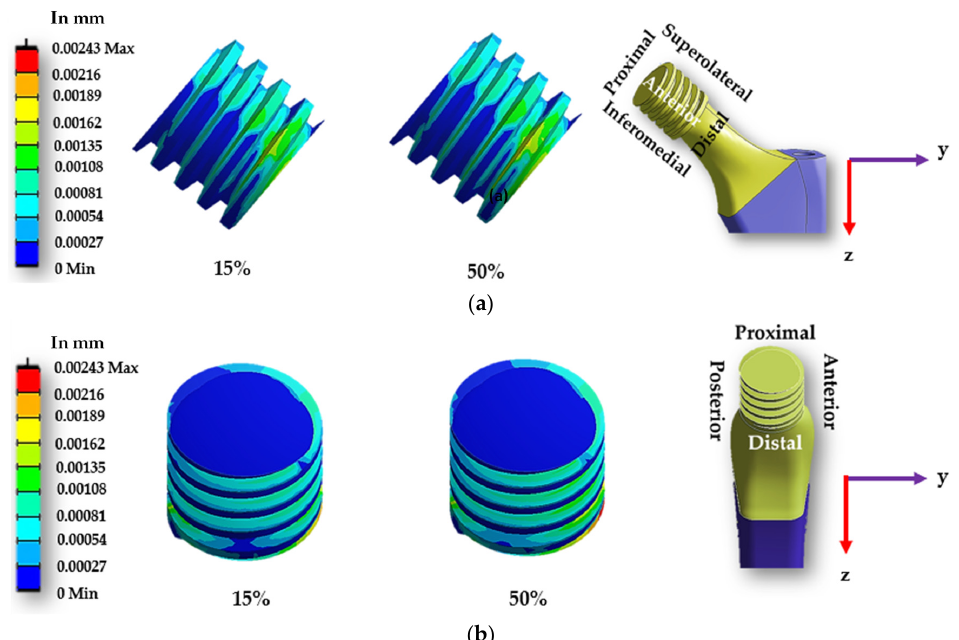
Figure 15. Sliding distance map over a spiral head-neck tapered joint from the ( a ) front and ( b ) right side for the walking loading condition.